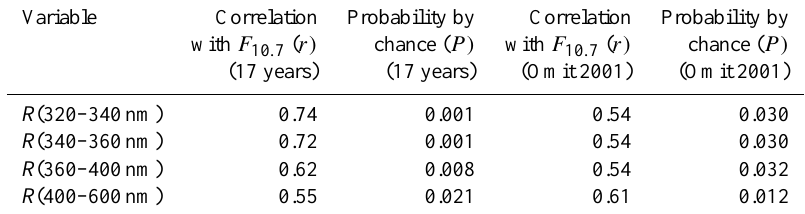
Table 3. Correlation of mean irradiance ratios R( λ) with the 10.7cm solar radio flux.